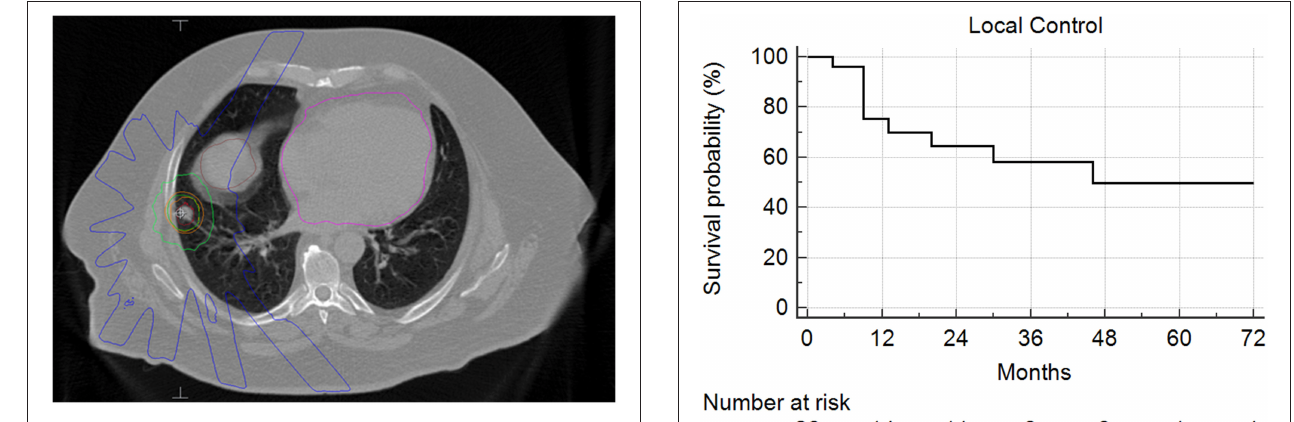
FIGURE 1 | Axial slice of an SBRT plan for a patient with a single lung metastasis from a colonic adenocarcinoma. He received 50Gy in 5 fractions. The red contour is the internal target volume (ITV) and the orange contour is the planning target volume (PTV). The dark green line is the 50Gy isodose line. The light green line represents the 25Gy isodose line and the blue line represents 10Gy. The brown structure is the liver and the magenta structure is the heart.